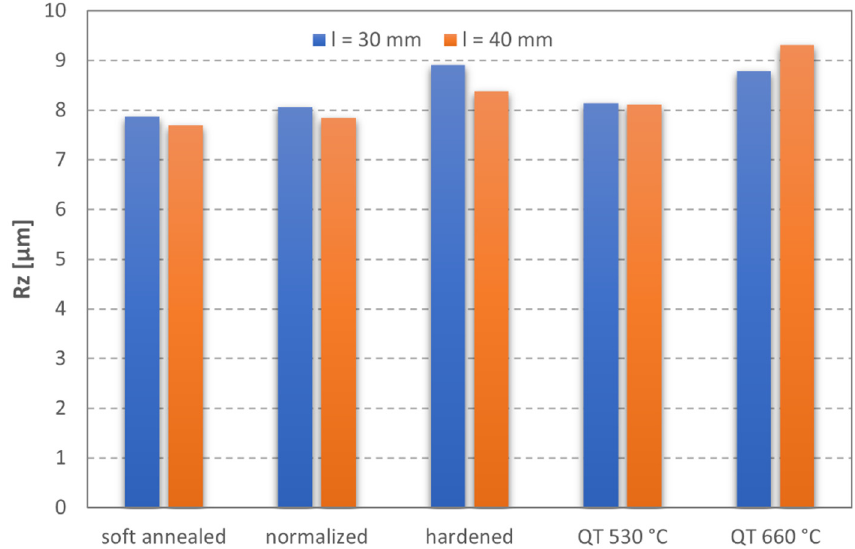
Figure 5. Comparison of the Rz parameter for the analyzed states of C45 steel.